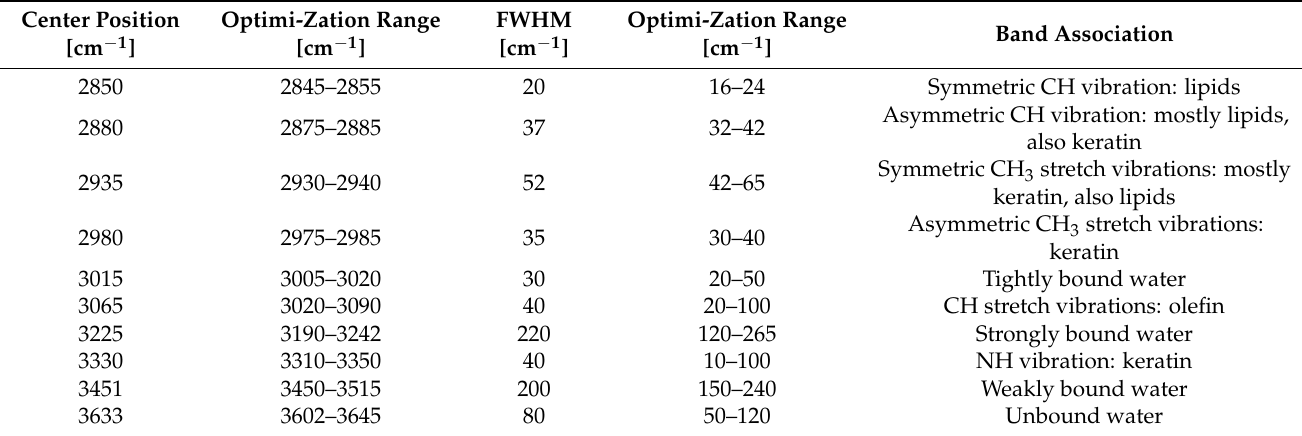
Table 1. Associations of the SC’s Raman bands in the high wavenumber (HWN) region calculated by decomposition using Gaussian